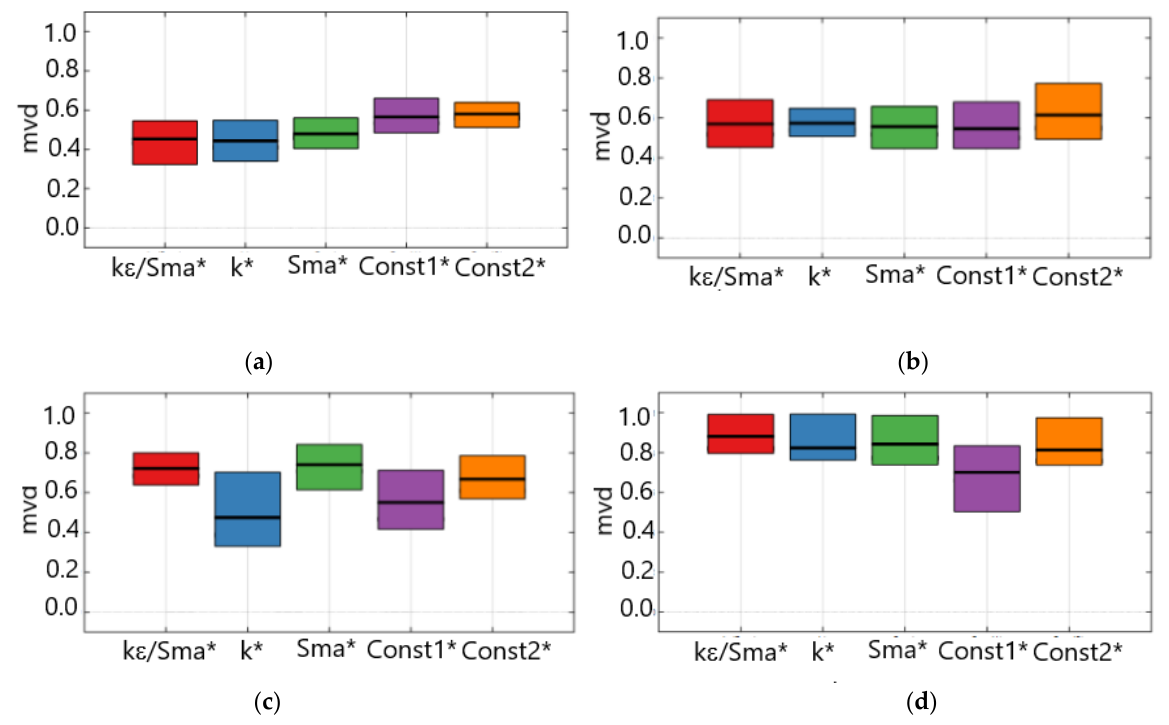
Figure 12. Mvd index for the temperature, for St1 ( a ), St2 ( b ), St5 ( c ), and St6 ( d ).